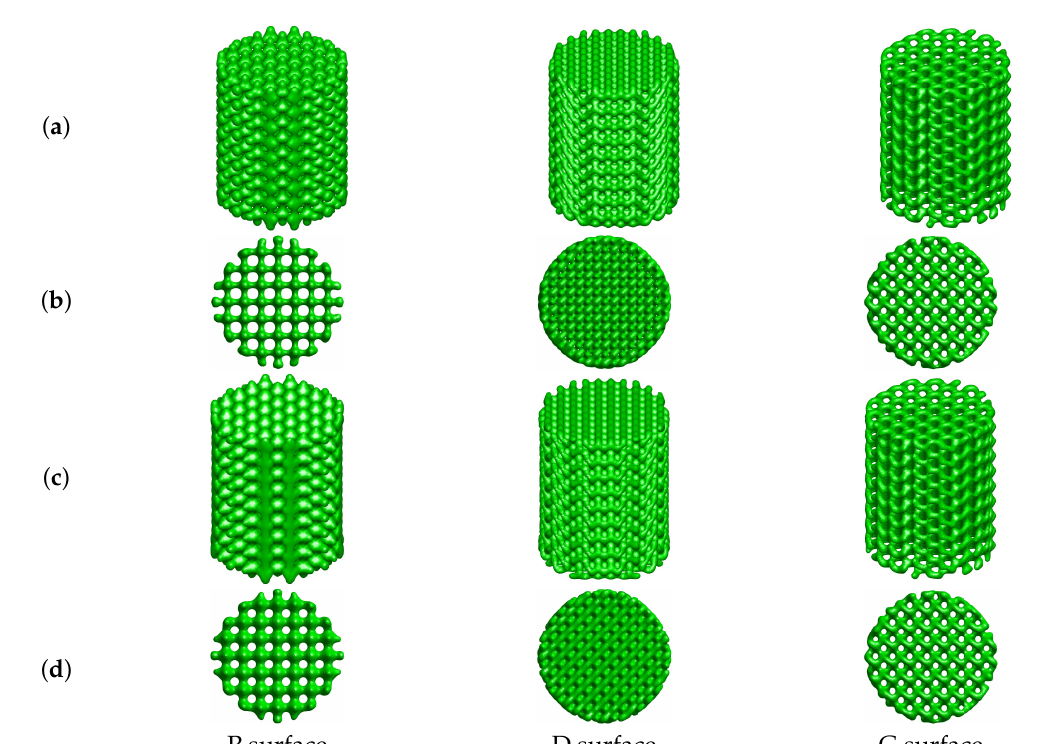
Figure 19. Comparison between phase separation of two methods at t = 50 ∆ t : ( a , b ) Equation (6) is solved on the domain Ω ; ( c , d ) φ s + 1 pqr for ( x p , y q , z r ) ∈ Ω in is updated with the initial condition.